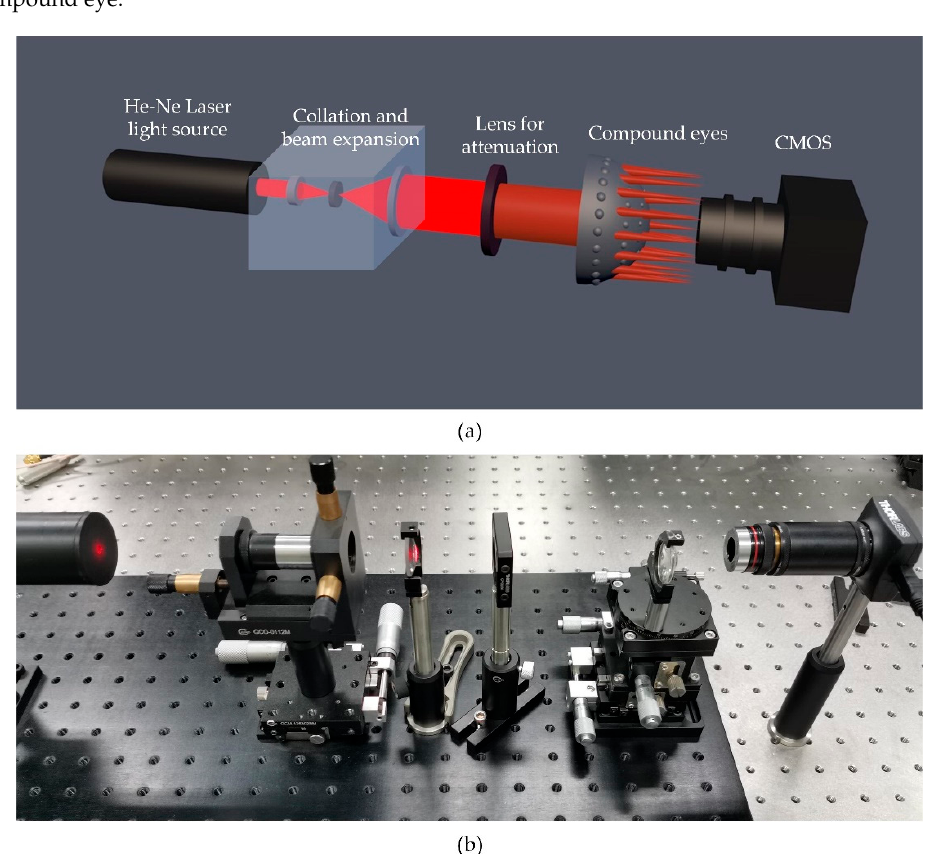
Figure 7. Experimental installation for optical performance: ( a ) schematic diagram of the setup; ( b ) actual platform comprised of He-Ne laser source, microscopic objective lens, pin hole, convex lens, MLAs, optical density filters, microscopic objective lens, and photodetector.